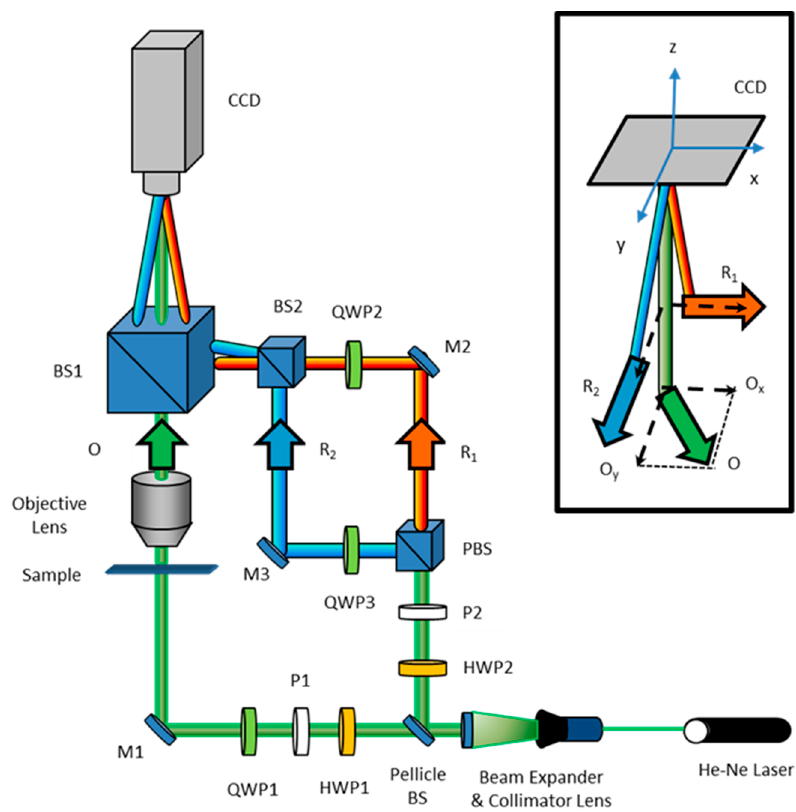
Figure 1. Basic scheme of the polarization-sensitive digital holographic imaging (PS-DHI) experimental setup. Abbreviations: M: mirrors; BS: beam splitter; PBS: polarized beam splitter; P: polarizer; QWP: quarter-wave plate; HWP: half-wave plate. In the inset, the incident directions and the polarization states of the object and reference waves are highlighted.